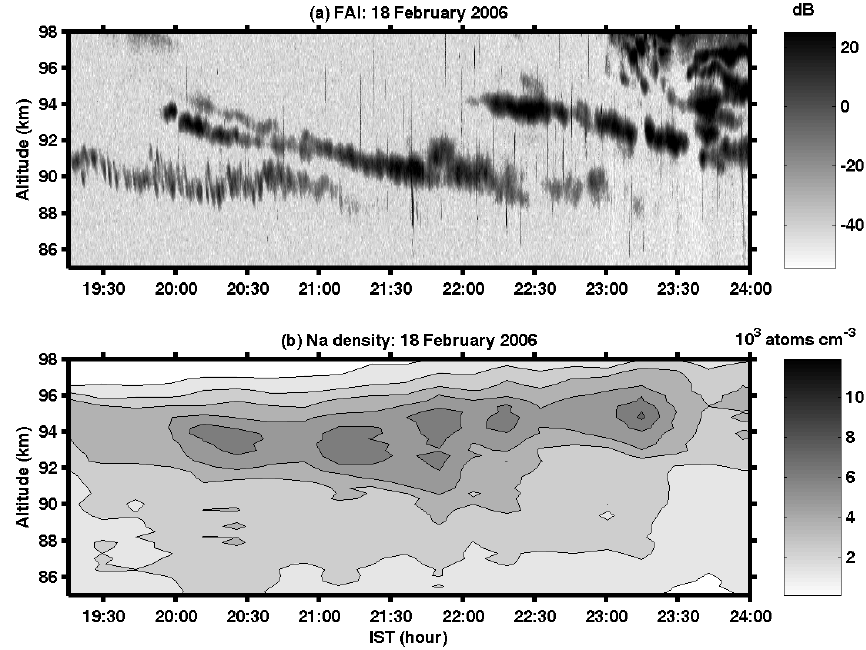
Fig. 1. Altitude-time cross section of intensity of echoes from FAI (top panel) and sodium density (bottom panel) for 18 February